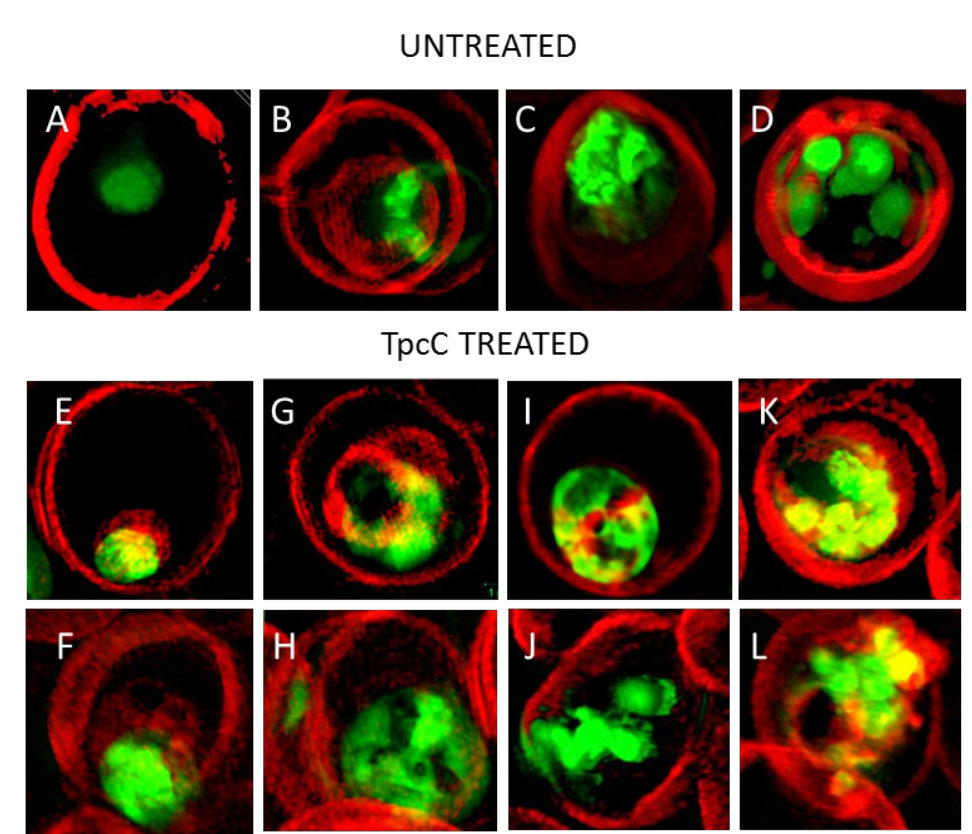
Figure 3. Super-resolution structured illumination fluorescence microscopy images of late intra-erythrocytic stages of P. falciparum D10 stained with the membrane impermeable fluorescent dye trypan blue (red) and the permeable nucleic acid fluorescent dye SYTO9 (green). Images ( A – D ) show untreated normal trophozoites and ( D ) a normal schizont. Images ( E – I ) show TpcC-treated trophozoites (post 6 h treatment) and ( J – L ) show TpcC-treated schizonts (post 6 h treatment). The arrows in ( I , H ) highlights the of dark irregular elongated structures, which could indicate hemozoin crystals, within or close to the nuclear material mass. Each image shows a single erythrocyte, with an average diameter of 7.5 µ m. Refer to Figure 4 more detailed magnification